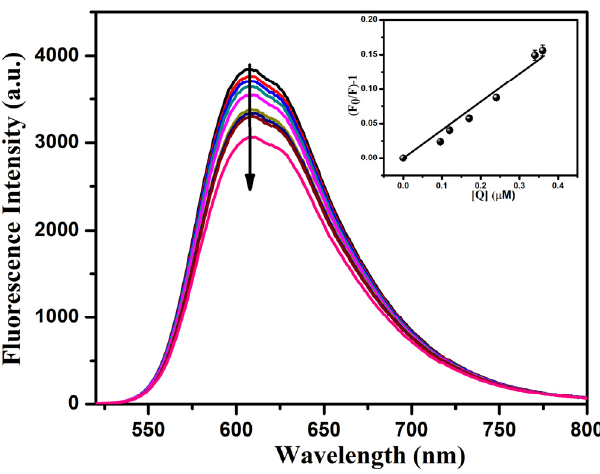
Figure 4. Quenching of EB (20 μ M) bound to ctDNA (100 μ M) upon addition of complex 1 (0–4.1 × 10 − 5 M) at 25 °C. Inset: Plots of (F 0 /F) − 1 vs. [Q].